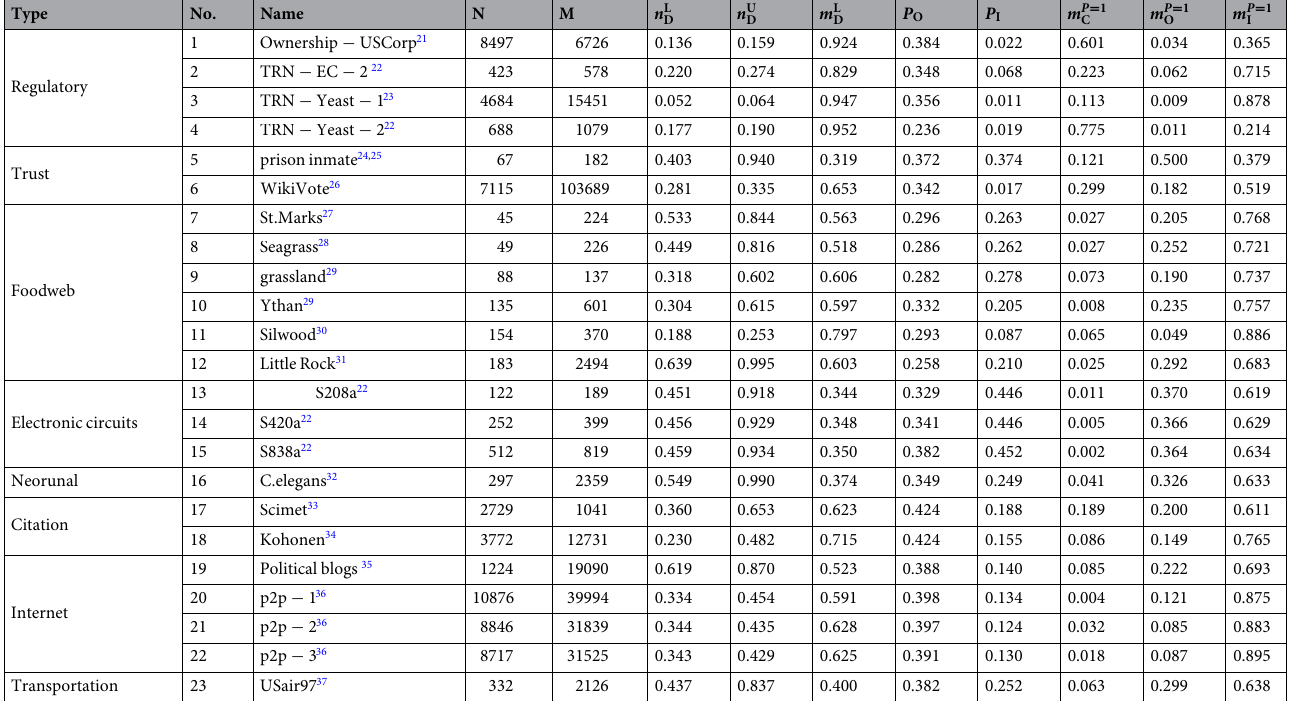
Table 1. Structural controllability of general edge dynamics in real network. For each network, we obtain its type, number, name, number N of nodes, number M of edges, the lower bounds (cid:31) n L D and m L D (cid:30) , the upper bound (cid:31) n U D and m U D (cid:30) , P O , P I and the proportions of the three kinds of edge (cid:31) m